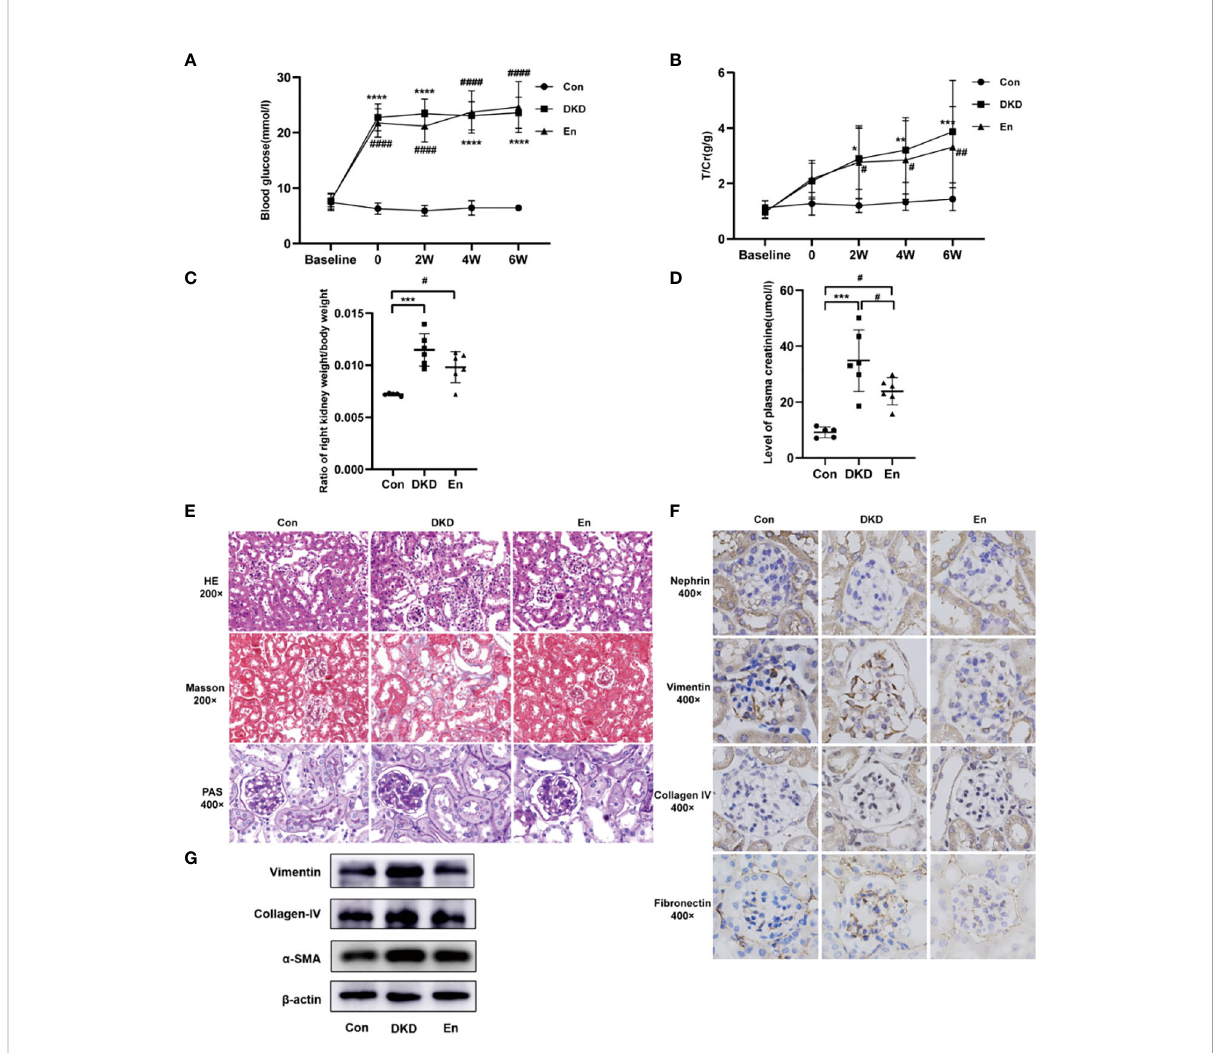
FIGURE 1 Analysis of general, laboratory and pathological indexes. (A, B) Line graphs of mouse RBG and T/Cr at different time points. (C) Scatter plot of ratio of right kidney weight/body weight. (D) Scatter plot of plasma creatinine. (E) HE/Masson/PAS staining of mouse kidney tissue in each group. (F) IHC staining of nephrin, vimentin, collagen IV, fi bronectin expression in kidney tissue. (G) Expression levels of vimentin, collagen IV, a -SMA in kidney tissue by Western blot analysis. *: DKD VS Con, # : En VS Con and En VS DKD. * and # p < 0.05, ** and ## p < 0.01, *** p < 0.001, **** and #### p <